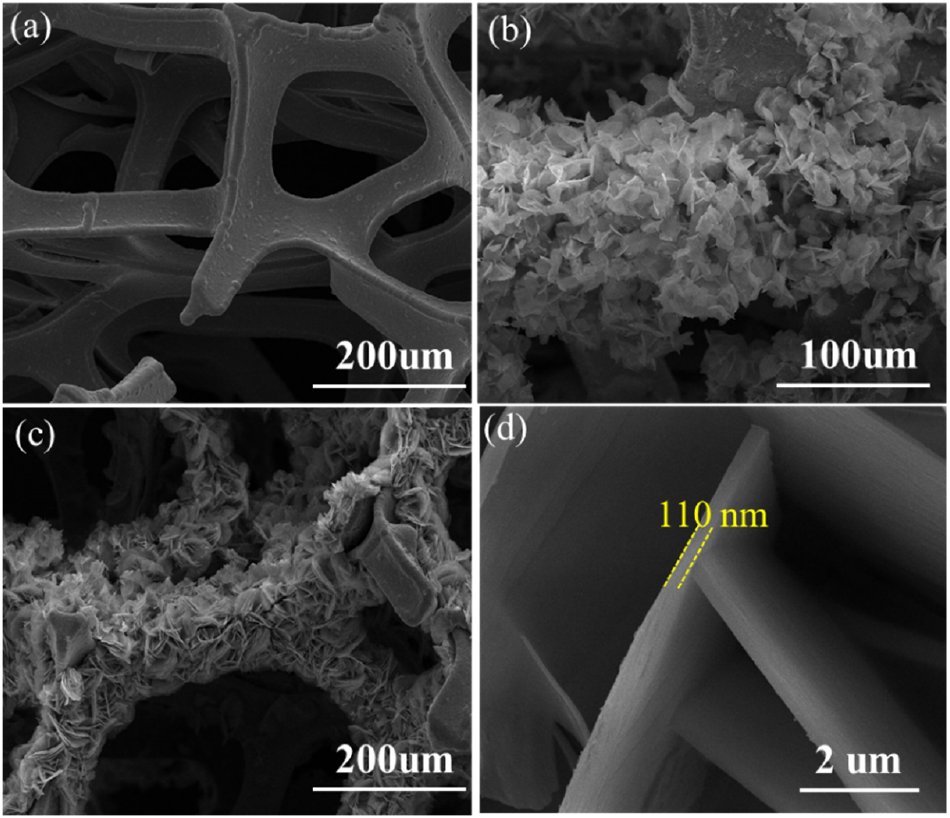
Figure 1. Characterization of as-prepared material: SEM images of NF ( a ), Co 3 O 4 /NF ( b ), and Co 3 O 4 − x /NF ( c , d ).